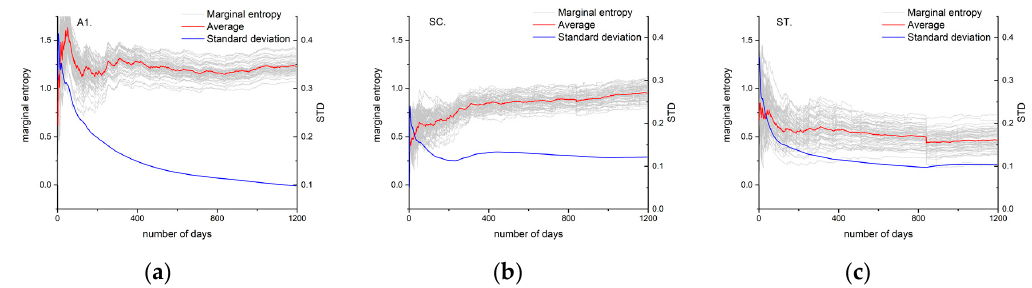
Figure 2. Marginal entropy statistics based on different discrete methods. ( a ) Statistical results based on the A1 discrete method; ( b ) Statistical results based on the SC discrete method; ( c ) Statistical results based on the ST discrete method.